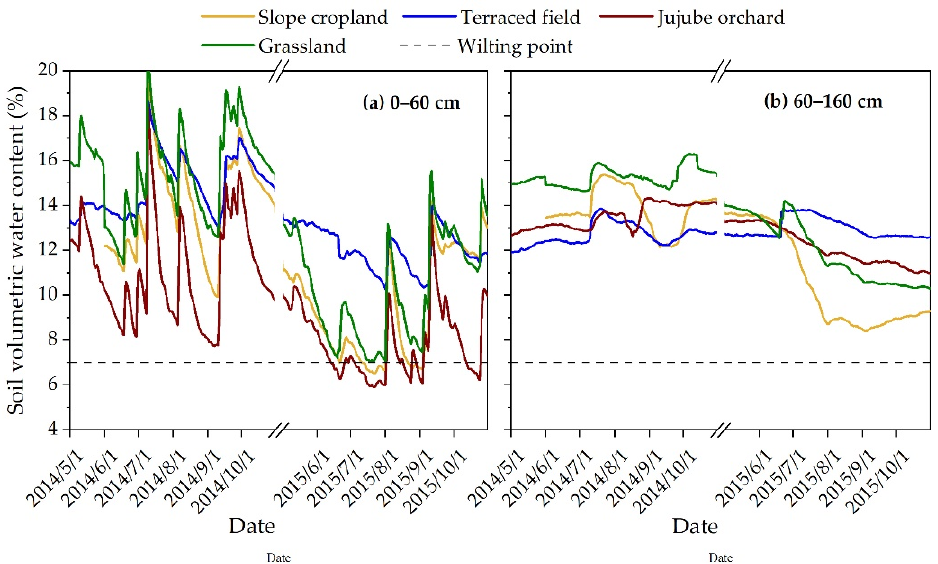
Figure 3. Variations in the daily average soil water content of the 0–60 cm ( a ) and 60–160 cm ( b ) soil layers during the growing season for various land uses. The daily mean soil water content of a soil layer for all land uses was calculated by averaging the soil water data collected by the EC-5 soil moisture sensor in a soil layer over one day.